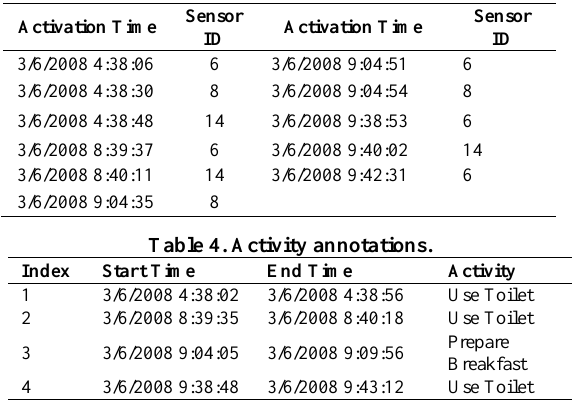
Table 3. Sensor data.